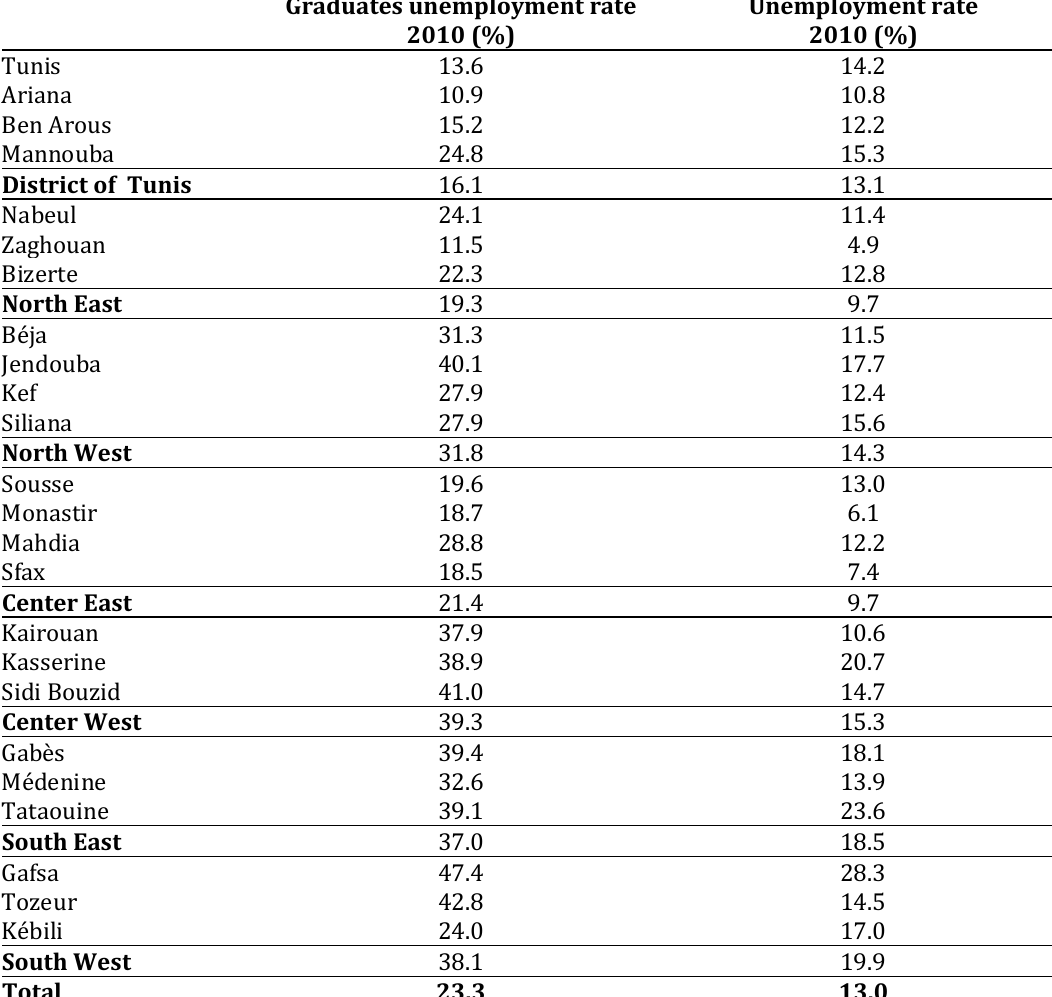
Table 6: Unemployment rates in Tunisia by governorate